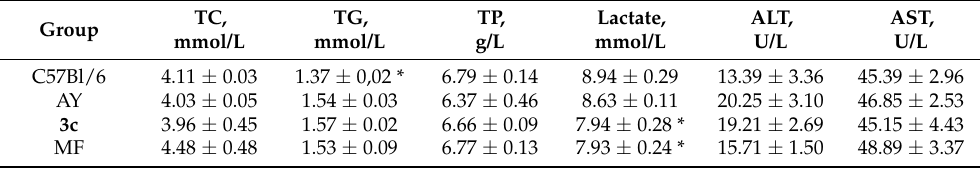
Table 4. Biochemical parameters of mouse blood. TC—total cholesterol, TG—triglycerides, TP—total protein, ALT—alanine aminotransferase, AST—aspartate transaminase. * p < 0.05 as compared to AY